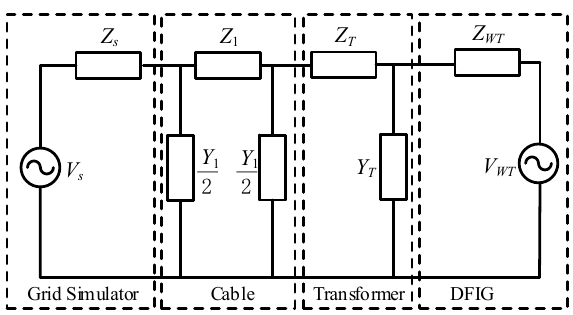
Figure 4. Equivalent circuit of the HA testing system.